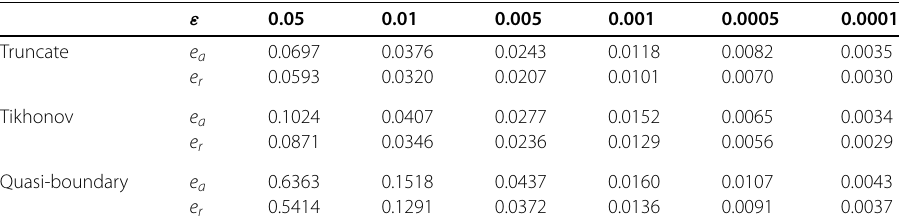
Table 1 Numerical results for different ε under an a posteriori choice rule for three regularization methods about Examples 1